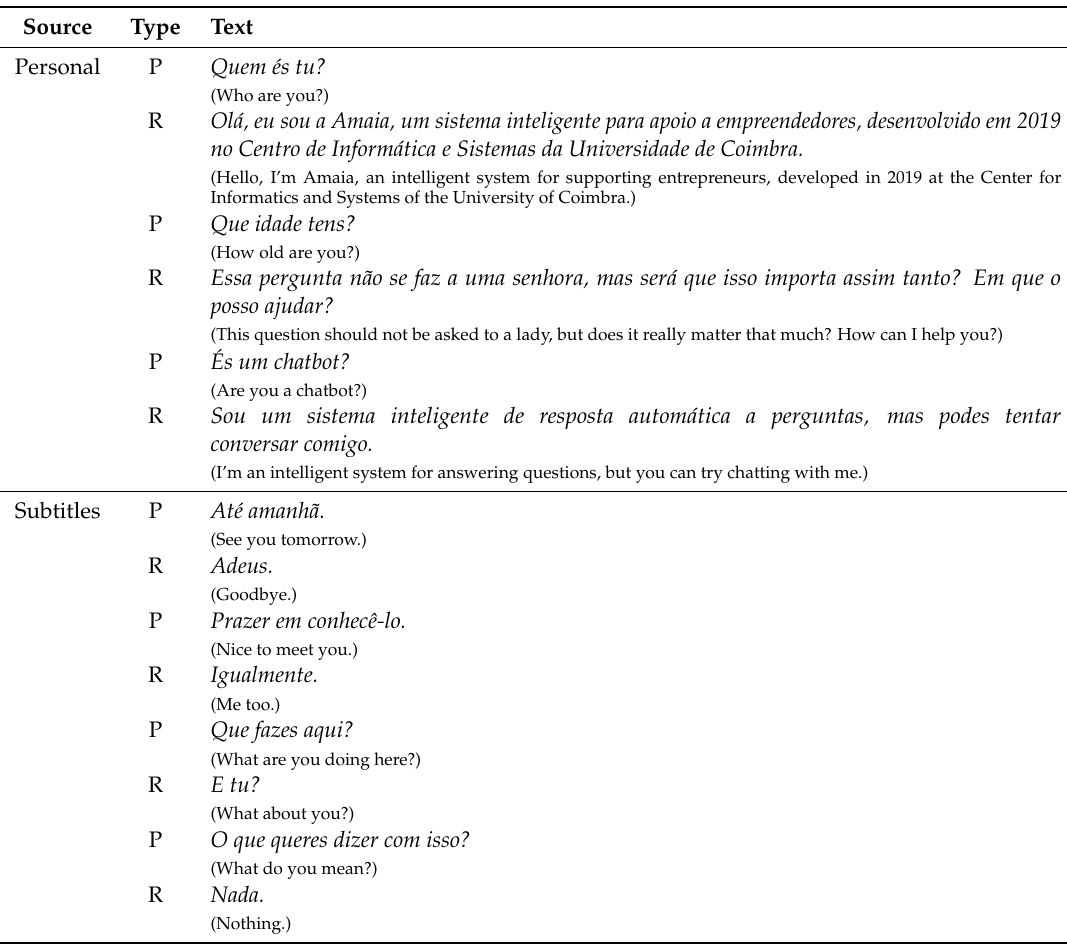
Table 2. Examples of the Chitchat